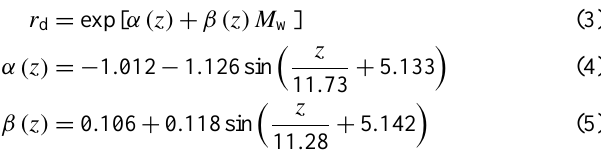
Table 2. Rod length correction with respect the depth.